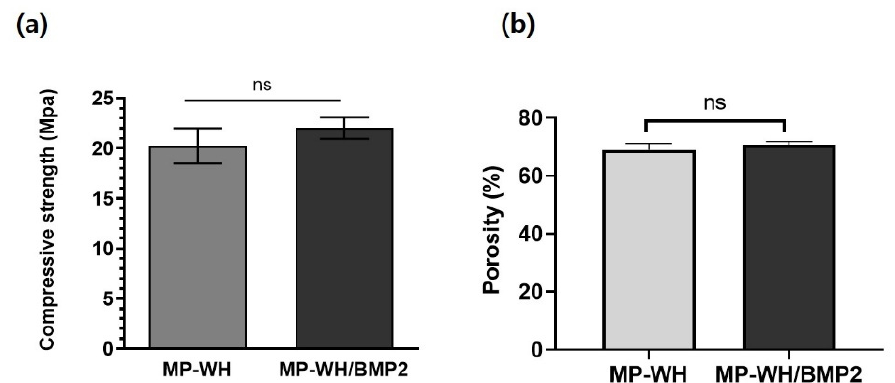
Figure 4. Measurements of the granules’ mechanical strength and porosity: ( a ) compressive strength and ( b ) porosity of the synthesized MP-WH and MP-WH/BMP2 granules. Data are means ± standard deviation (SD) over three samples. “ns” indicates significant differences, compared with the uncoated three-dimensional scaffolds ( p < 0.01).